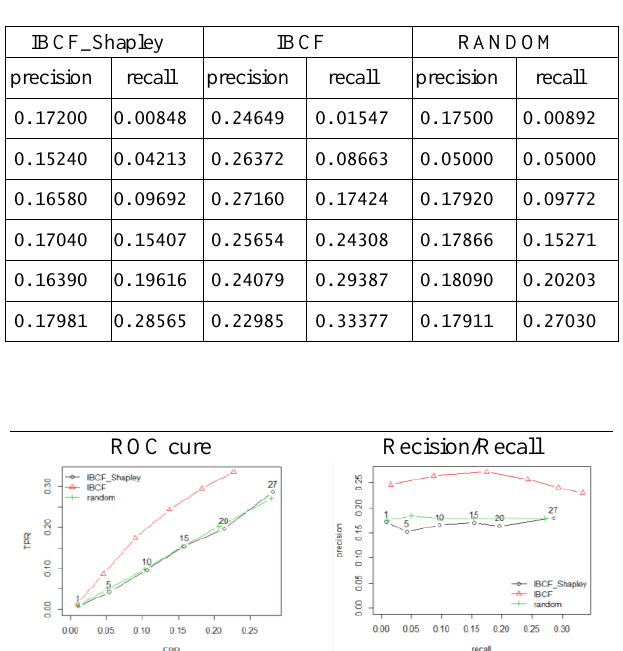
Figure 6. ROC curve of three models